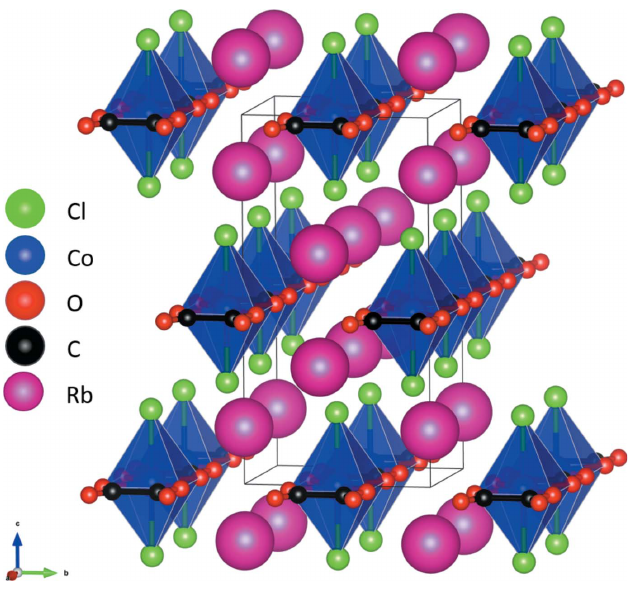
Figure 4 The crystal structure of Rb 2 CoCl 2 (C 2 O 4 ) (II) in a view approximately along the a